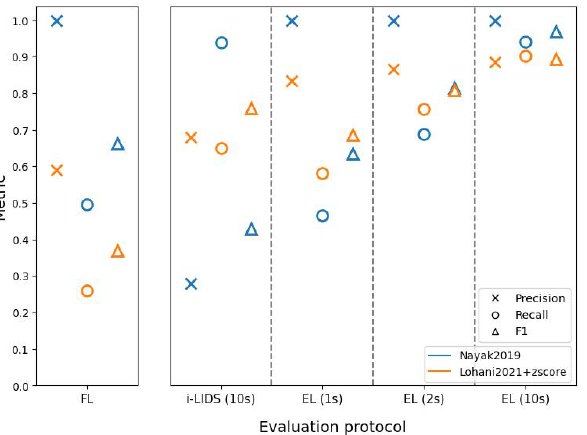
Figure 14. The results on view 2 of i-LIDS test set for two methods: Nayak et al. [47] (in blue) and Lohani et al. [6] with z-score (in orange). The abscissa represents three evaluation protocols: frame- level (FL) (on left subfigure), i-LIDS and edge-level (EL) (on right subfigure). i-LIDS is evaluated by default for 10 s whereas, for EL, we show results for 1, 2 and 10 s. The ordinate represents values of three metrics: precision, recall and F 1